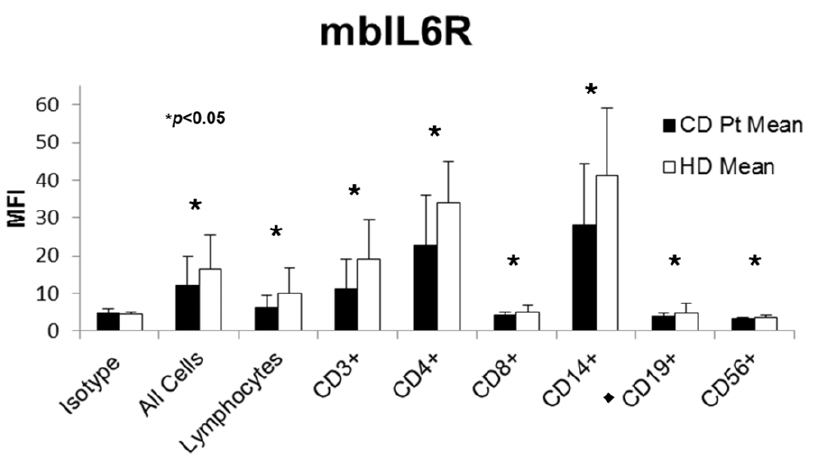
Figure 3. Mean mbIL6R levels. Levels of mbIL6R were measured by flow cytometry. Mean mbIL6R levels for HD (n=50, white) are significantly greater than levels for CD patients (n=58, black) on all cell types measured. CD19 data is omitted from 5 patients who received rituximab (black diamond).